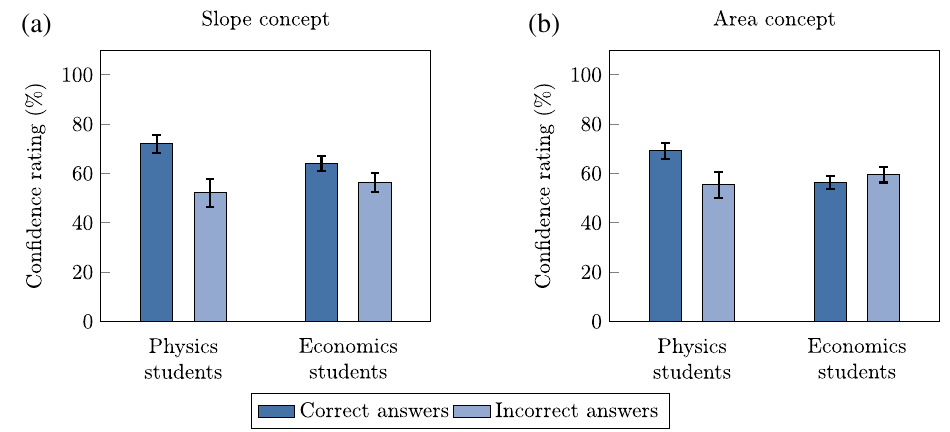
FIG. 5. Average confidence ratings of physics and economics students associated with correct and incorrect answers on (a) the slope questions and on (b) the area questions. The error bars represent 1